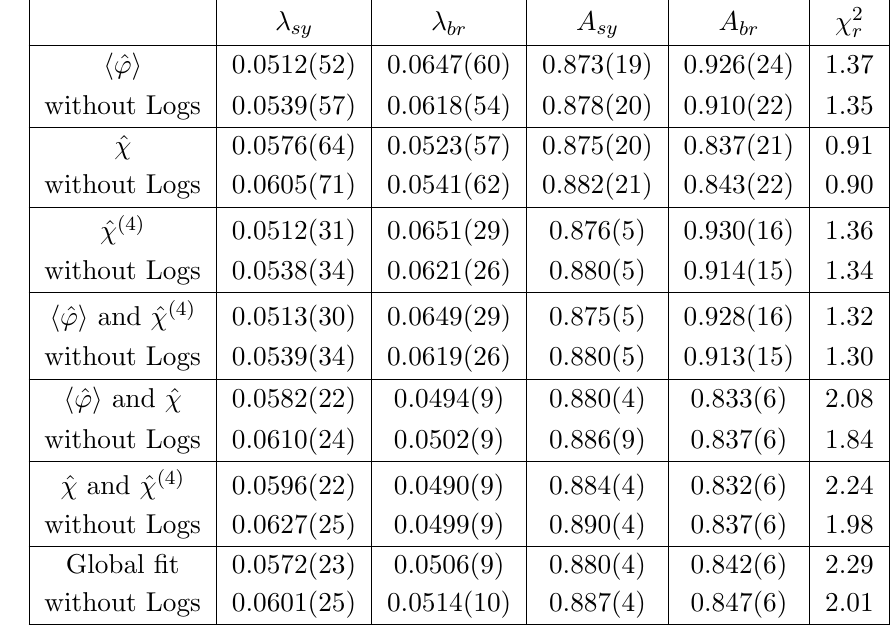
Table 2 . A summary of all (cid:12)t parameters from all scaling tests performed: individual, global and combination of two